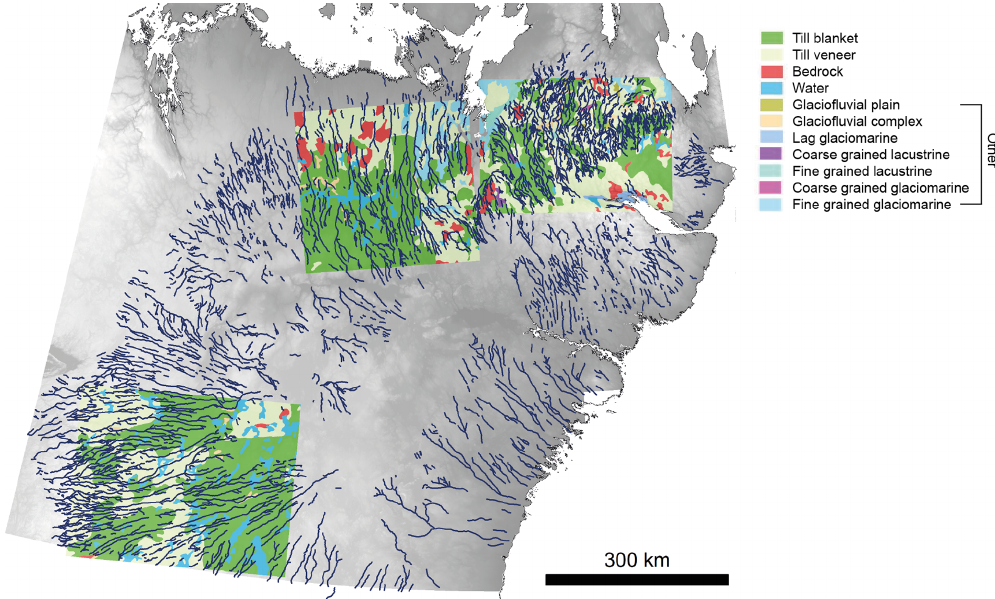
Figure A2. Surface substrate across the three test sites (left–right) used for analysis in Sect.